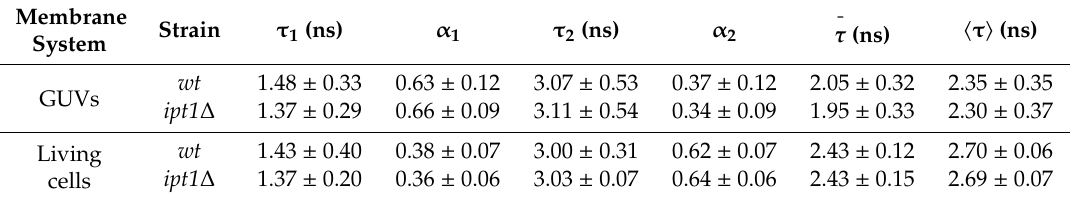
Table 2. Fluorescence intensity decay parameters of di-8-ANEPPS incorporated in S. cerevisiae wt and ipt1 ∆ cells at 24 ◦ C. The fluorescence intensity decays measured in cells were described by the sum of two exponentials, with amplitudes α 1 and α 2 and lifetimes τ 1 and τ 2 . τ av is the amplitude-weighted mean fluorescence lifetime and (cid:104) τ (cid:105) is the intensity-weighted mean fluorescence lifetime (Equations (3) and (4)). The values are the mean ± S.D. of more than 50 GUVs from three biological replicates and ca. 400 cells from four biological